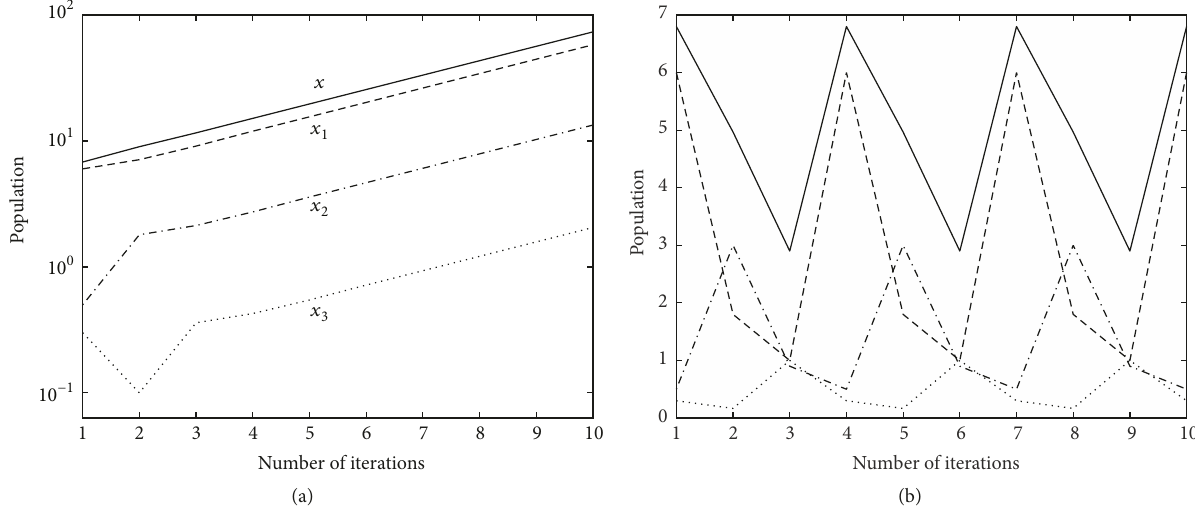
Figure 1: (a) Dynamics generated by map (3). (b) Dynamics generated by map